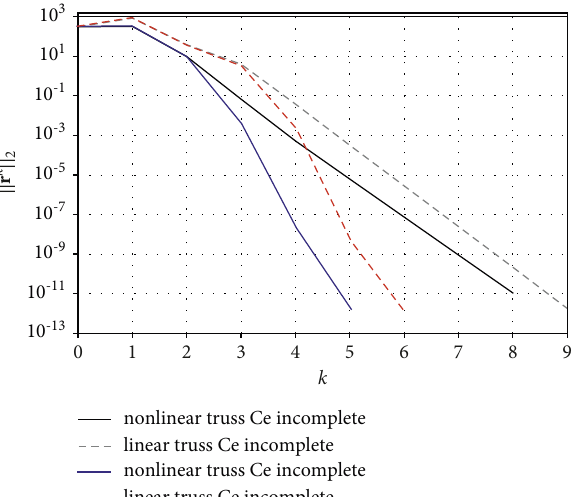
e from equation 57 or the